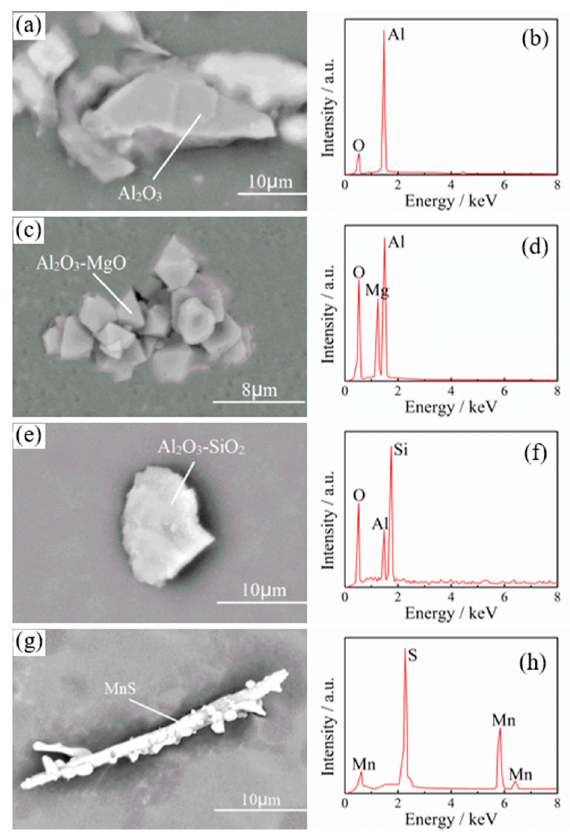
Figure 2. Three-dimensional morphologies, ( a ) Al 2 O 3 , ( c ) Al 2 O 3 -MgO, ( e ) Al 2 O 3 -SiO 2 , and ( g ) MnS; and compositions of inclusions, ( b ) Al 2 O 3 , ( d ) Al 2 O 3 -MgO, ( f ) Al 2 O 3 -SiO 2 , and ( h ) MnS.